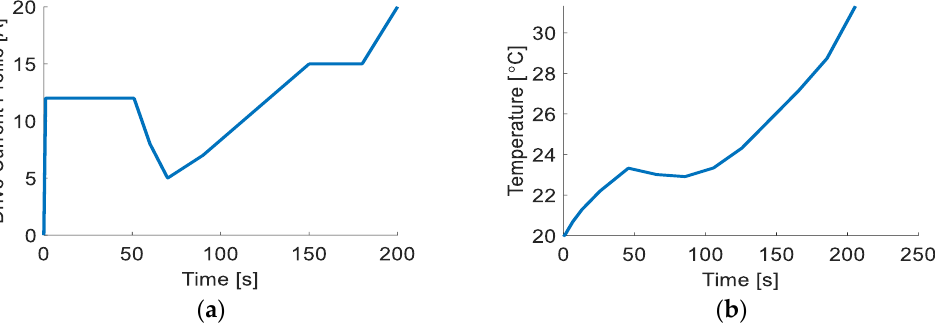
Figure 12. ( a ) First custom drive current profile and corresponding ( b ) predicted temperature profile.